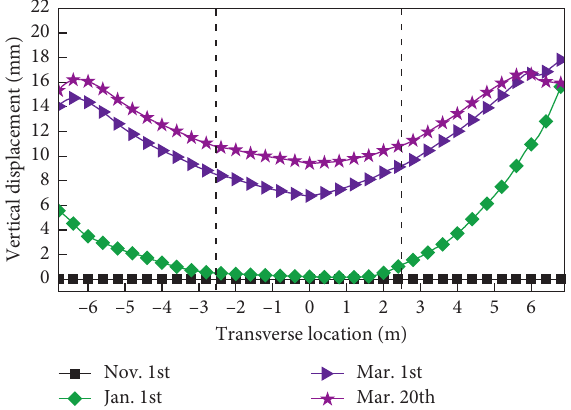
Figure 9: Vertical displacements of roadbed section at different moments.